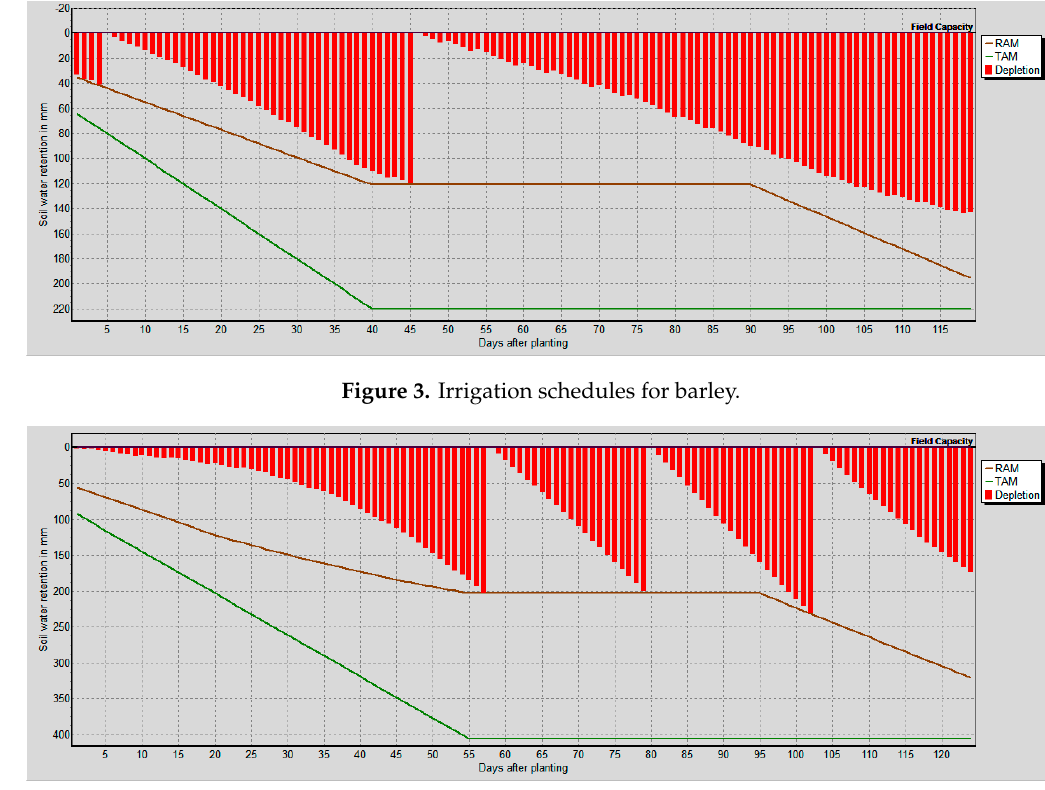
Figure 4. Irrigation schedules for white corn. Table 10. Irrigation schedules for tomatoes.